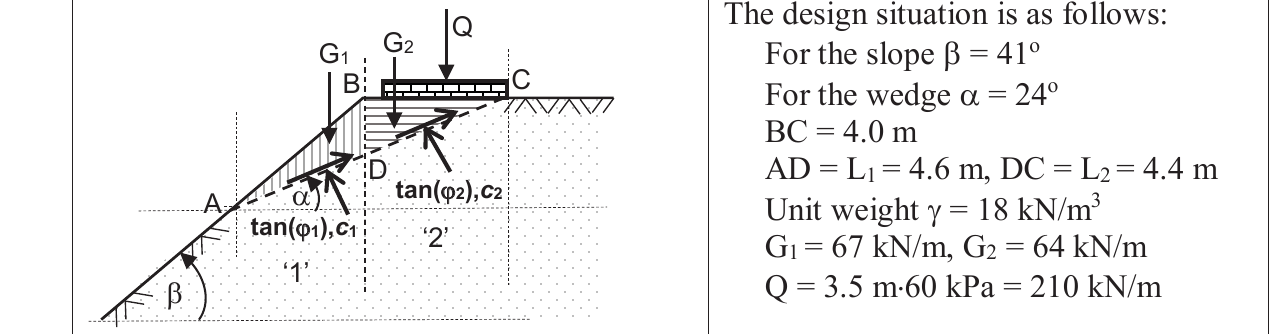
Figure 6: Simplified wedge stability for 2 x 2 random variables tan( j